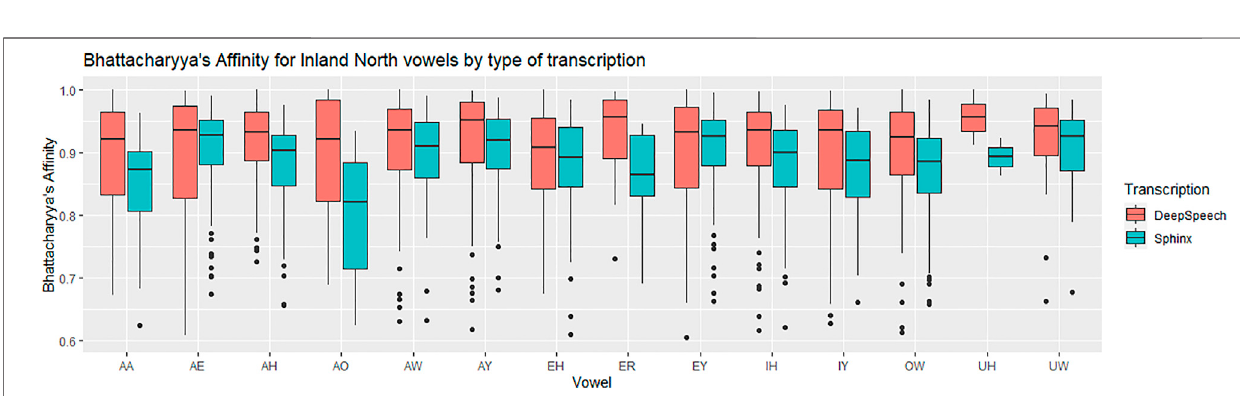
behaviour of DeepSpeech transcribed vowels is similar to that of the vowels in the ground truth transcriptions. There is one vowel, stage 1 AE, where both ground truth and DeepSpeech found signi fi cant differences between General and Inland North vowels: ground truth shows a difference of Δ Region GT (cid:1) 0.83 and DeepSpeech shows a signi fi cantly smaller but non-zero difference of Δ Region GT (cid:1) 0.65 [ β GT:InlandNorth (cid:1) − 0.02 ± 0.008, t (256) (cid:1) − 2.0, p < 0.05]. Even though the distance between General and Inland North is smaller for DeepSpeech, it is signi fi cantly different from zero, as shown by the post-hoc analysis (z (cid:1) 4.8, p < 0.0001). On the other hand, there are three vowels (stage 3 AO and stage 4 EH and stage 5 AH) where neither DeepSpeech nor the ground truth data could see signi fi cant differences between General and Inland vowels. For example, EH showed raising differences of Δ Region GT (cid:1) 0.21 and (cid:1) 0.18, but neither of these were signi fi cantly different Δ Region GT from zero ( p (cid:1) 0.88 and p (cid:1) 1.0 respectively). In summary, for these